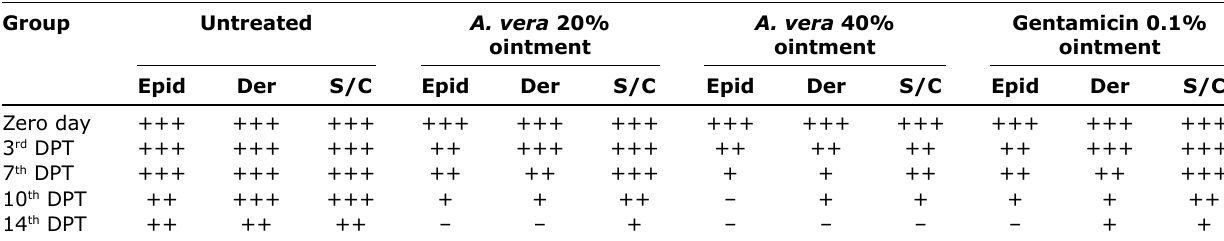
Table-4: Histopathology scoring of dog’s skin inflammation and its location after experimental inoculation with S. aureus and topical treatment with A. vera 20% and 40% and gentamicin 0.1% ointments. Group